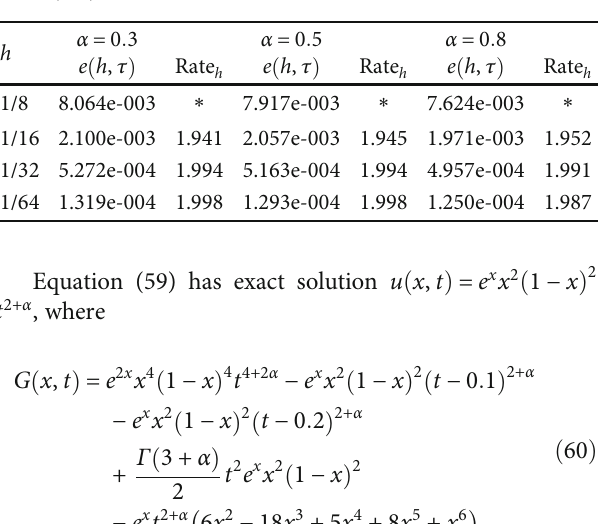
Table 4: Simulation results of Example 11, where τ = 1/2000 and α = 0 : 3,0 : 5,0 : 8 .